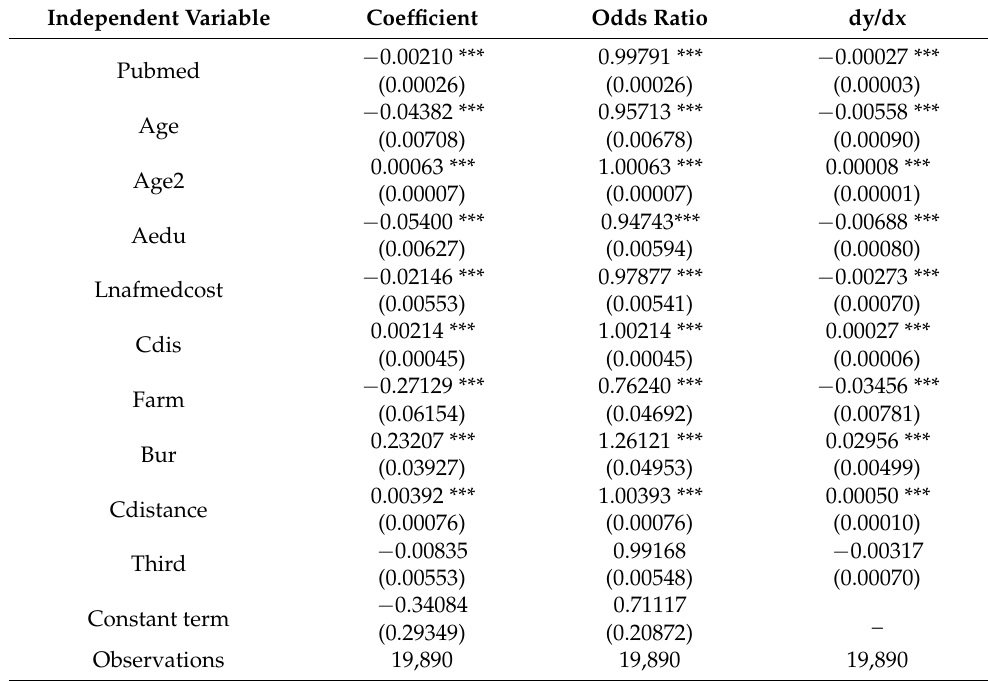
Table 2. Logit regression of poverty reduction by public health